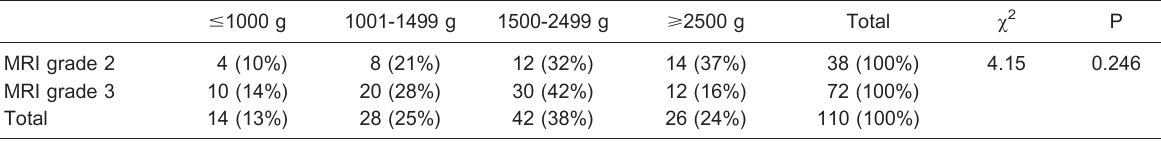
Table 6. Magnetic resonance imaging findings according to the birth weight in children with hypoxic-ischemic